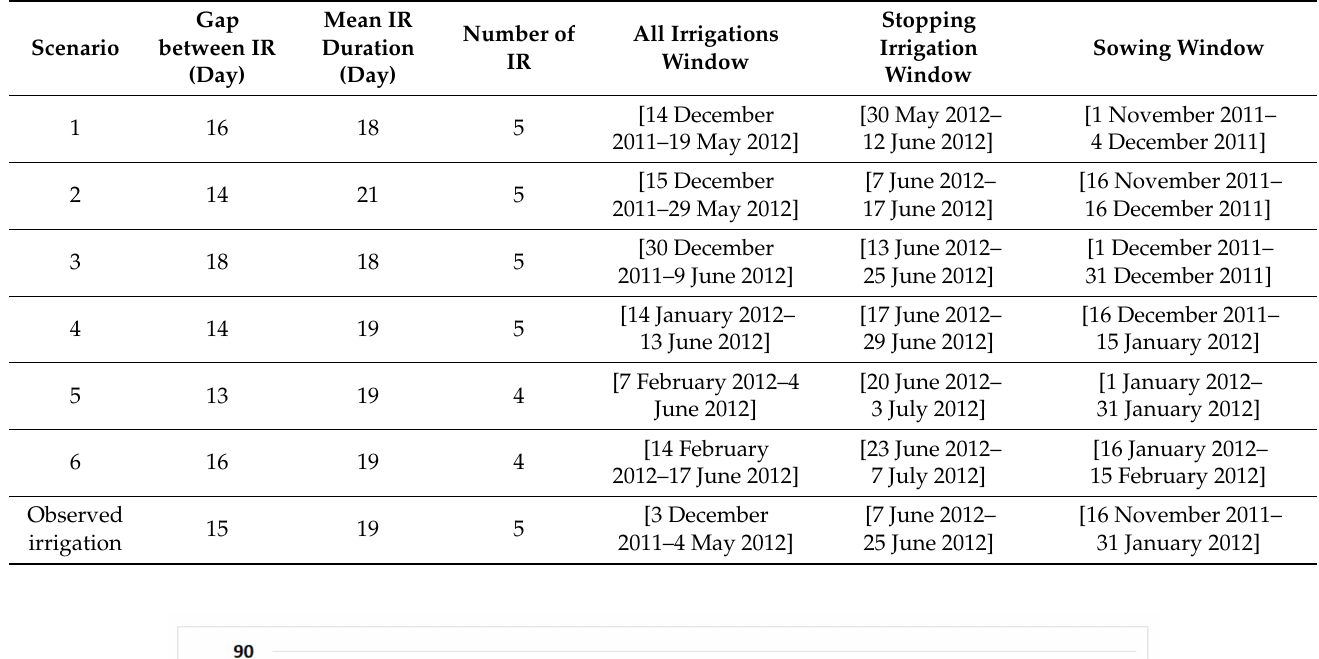
Table 3. Optimized irrigation windows, sowing windows, stopping irrigation window, number and mean duration of irrigation round (IR) and the mean gap between two successive irrigation rounds.